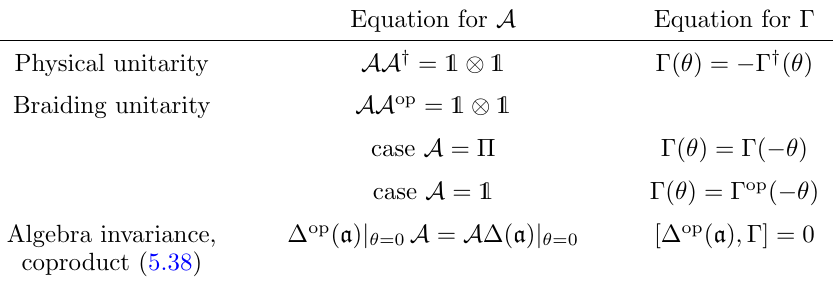
Table 1 . Summary of the conditions for ((cid:0) ; A